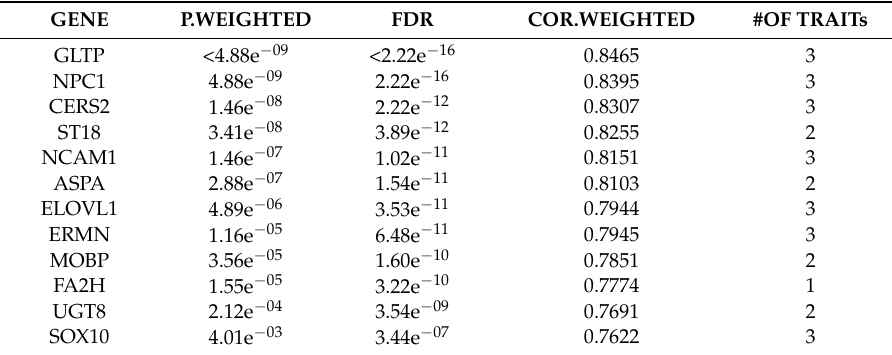
Table 2. Transcripts associated with myelin or sphingolipid.